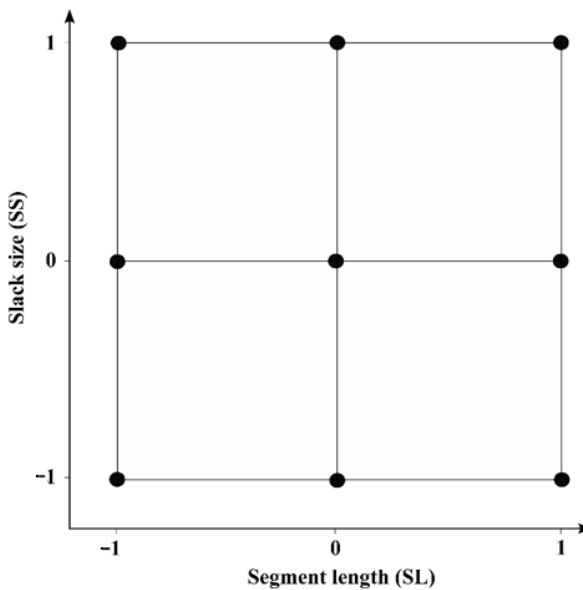
Figure 5. Three-level full factorial design, with − 1 representing the lowest level of both factors (SL and SS), 0 representing the intermediate level, and 1 representing the highest level. Table 4. SL and SS level values used in the full factorial designs.